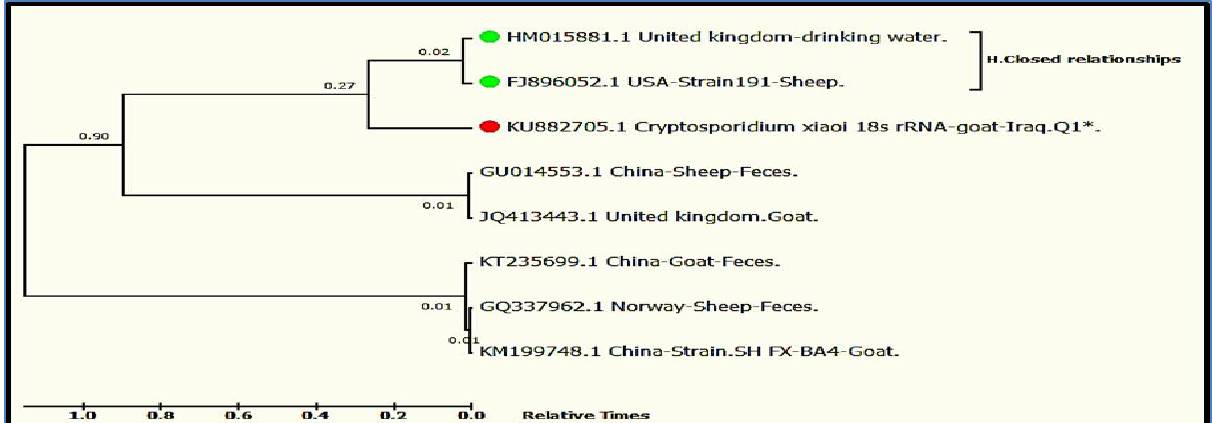
Figure, 6: Phylogenetic tree depend on the Neighbor joining tree method. The phylogenetic distances analyses were conducted by MEGA6.*Red spot: C. Xiaio strain isolated from Iraq.*Green spot: Strain high homologous with Iraqi – C. Xiaio isolated from goat.